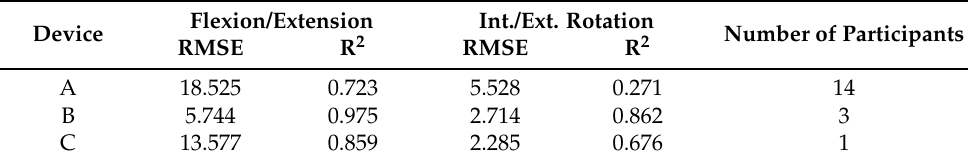
Table 2. RMSE and R 2 values of the device-specific